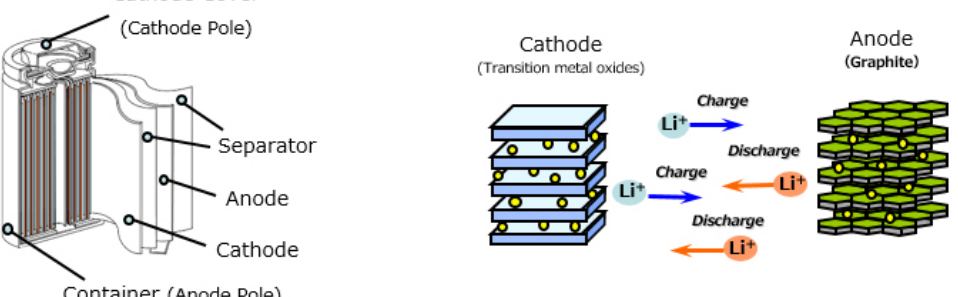
Figure 9. Schematic view of the PEMFC (adapted with permission from Ref. [45]). Fiber-shaped supercapacitors due to their higher performance are promising energy storage devices for future portable electronic devices. A fiber-shaped asymmetric supercapacitor (ASC) device is composed of metal oxides and directly grown on a flexible and conductive carbon fiber substrate which makes a large work function difference. Specifically, carbon fiber/MoO 3 (CF/MoO 3 ) and carbon fiber/MnO 2 (CF/MnO 2 ) are produced using a simple electrodeposition approach. The solid fiber-shaped ASC device is then assembled with CF/MoO 3 as the negative electrode and CF/MnO 2 as the positive electrode. The high work function difference between the high conductivity of the carbon fiber substrate and the metal oxides leads to the ASC device with notable performance. Figure 10 illustrates the overall procedure to assemble the ASC device based on CF/MoO 3 as the negative electrode and CF/MnO 2 as the positive electrode [46].